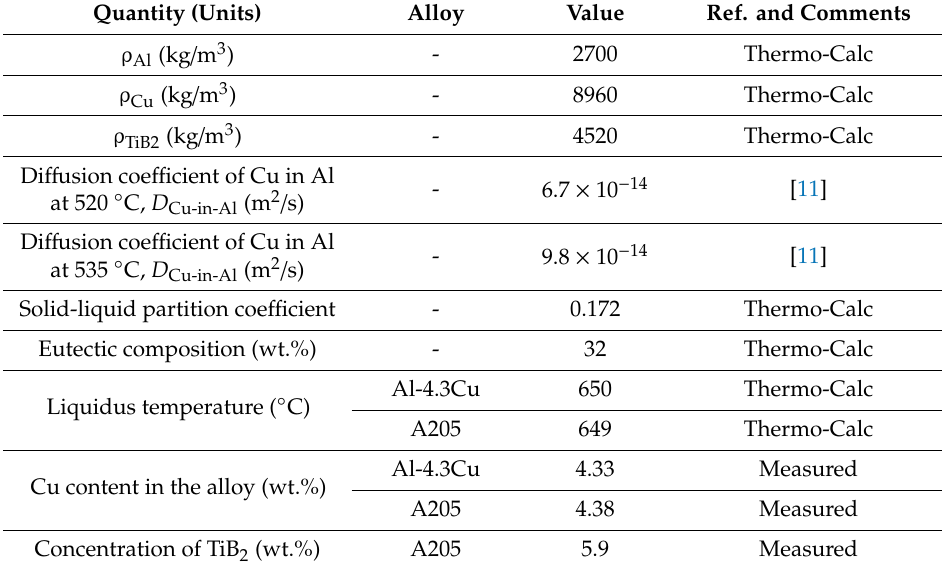
Table 3. Model inputs.